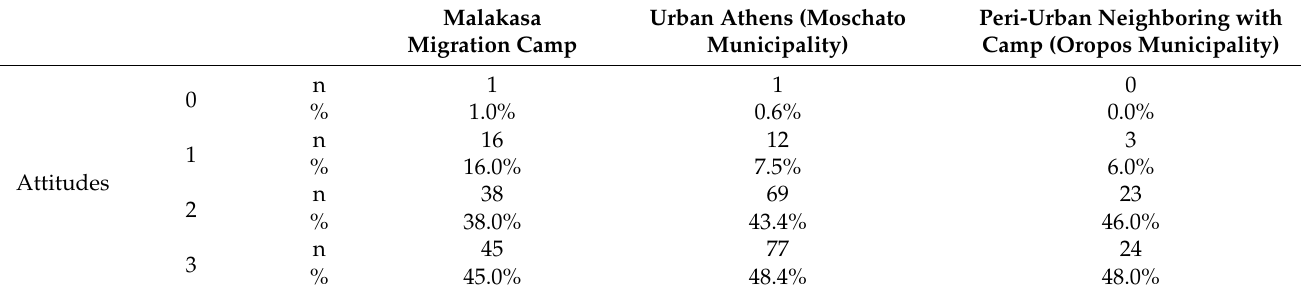
Table 4. Attitude score: Correct answers to Attitude Questions.